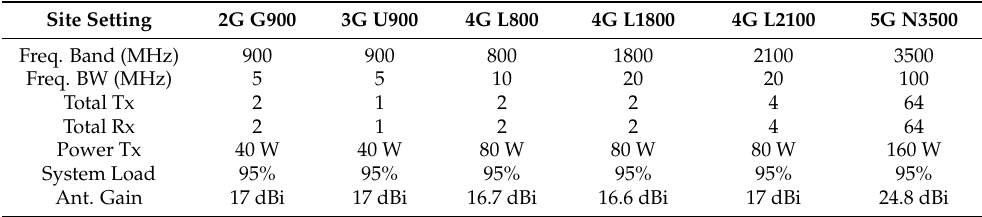
Table 2. Configuration setup for macro